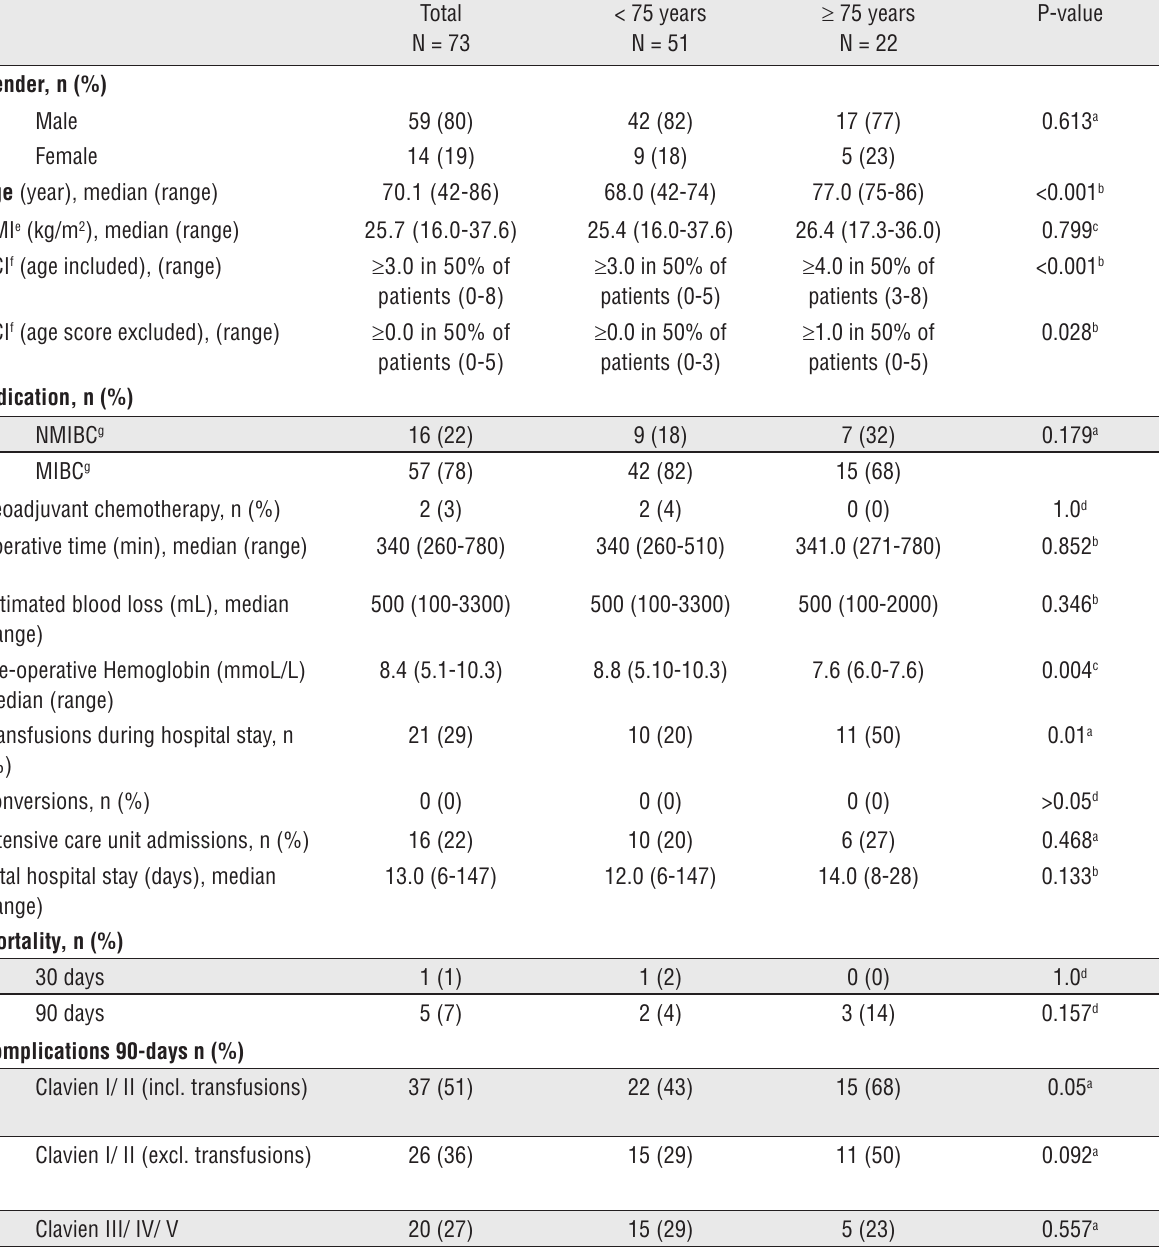
Table 1 - pre-, per-, and postoperative patient